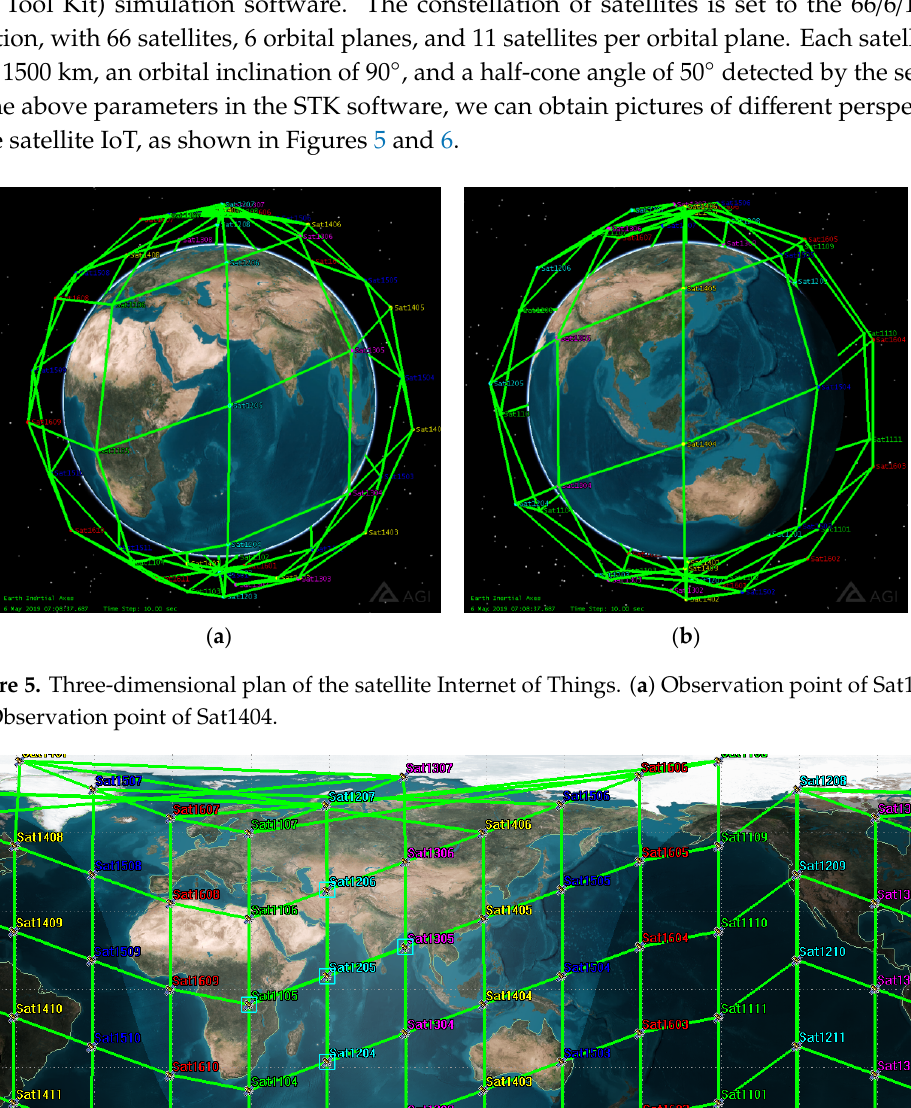
Figure 6. Two-dimensional plan of the satellite Internet of Things.